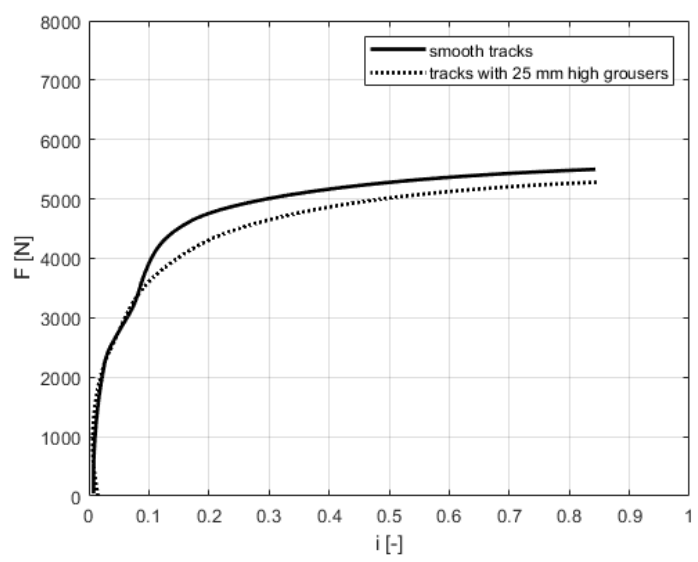
Figure 20. Traction force-slip curves on